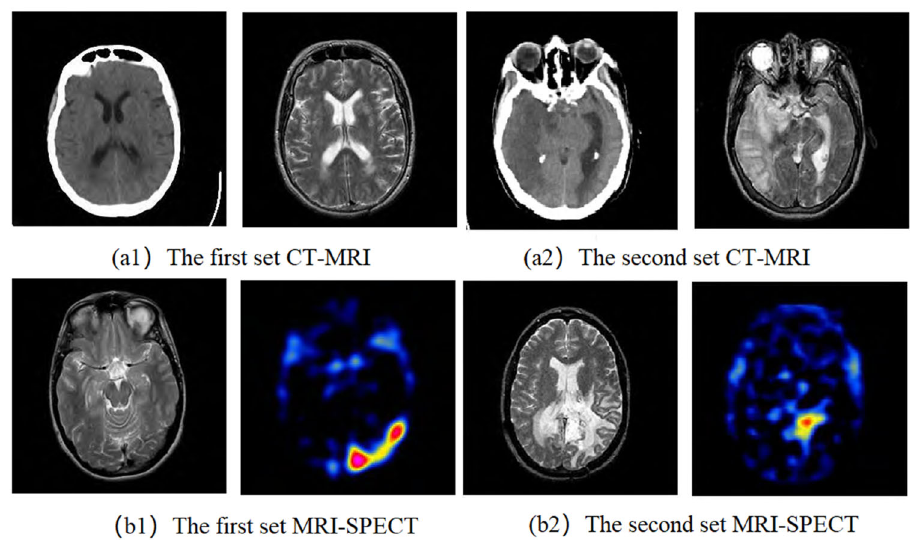
Fig. 3 Experimental source images: a